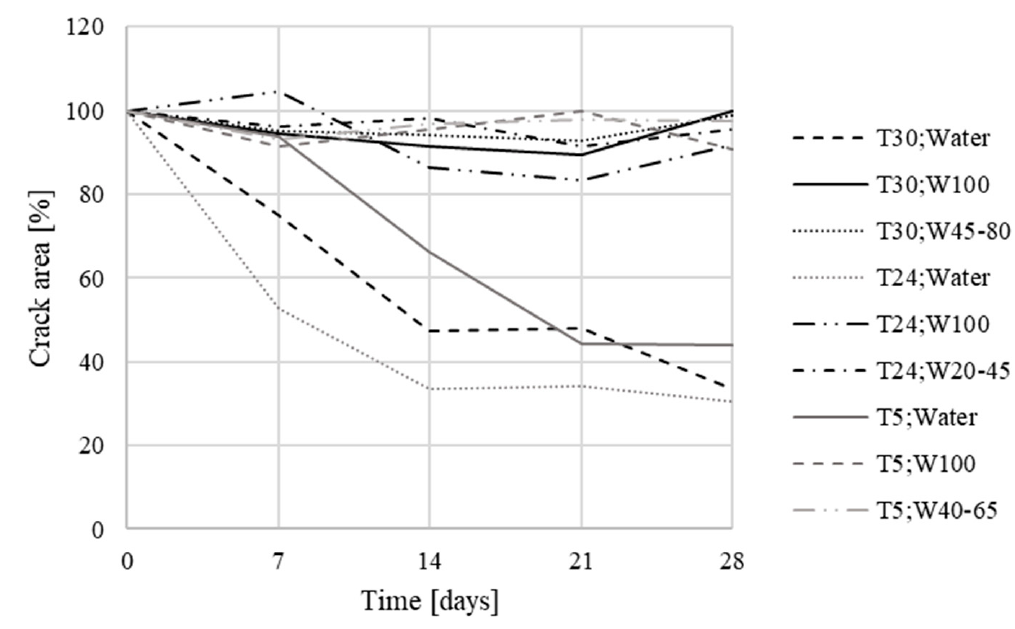
Figure 10. Crack development in specimens with Xypex Admix additive—the first phase (T = temperature, W = humidity).